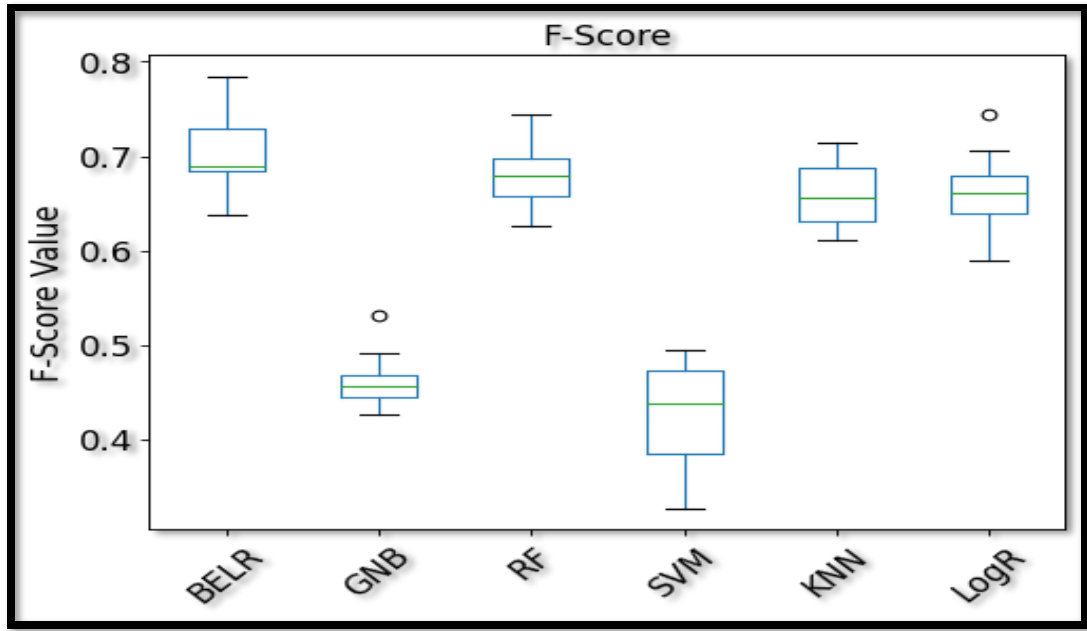
Figure 6. The average F1-score of the compared algorithms.